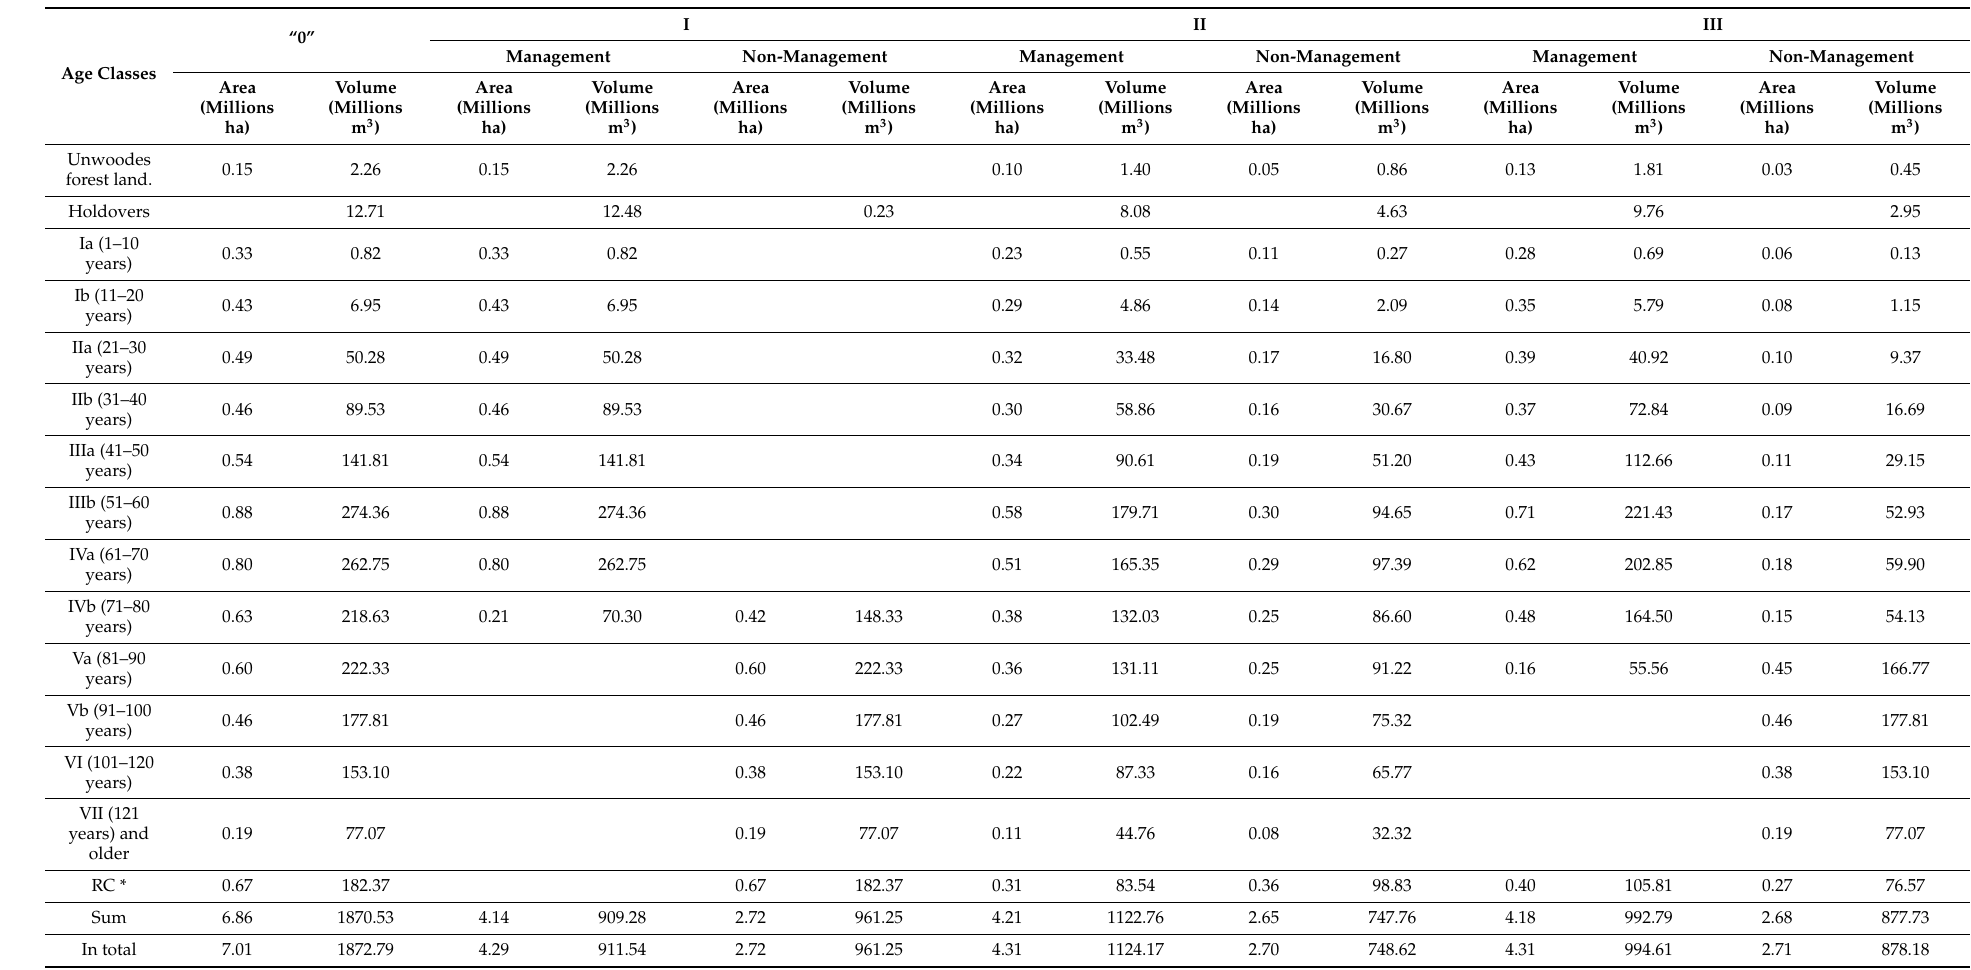
Table 1. The area and volume of stands in age classes and subclasses according to scenarios and their